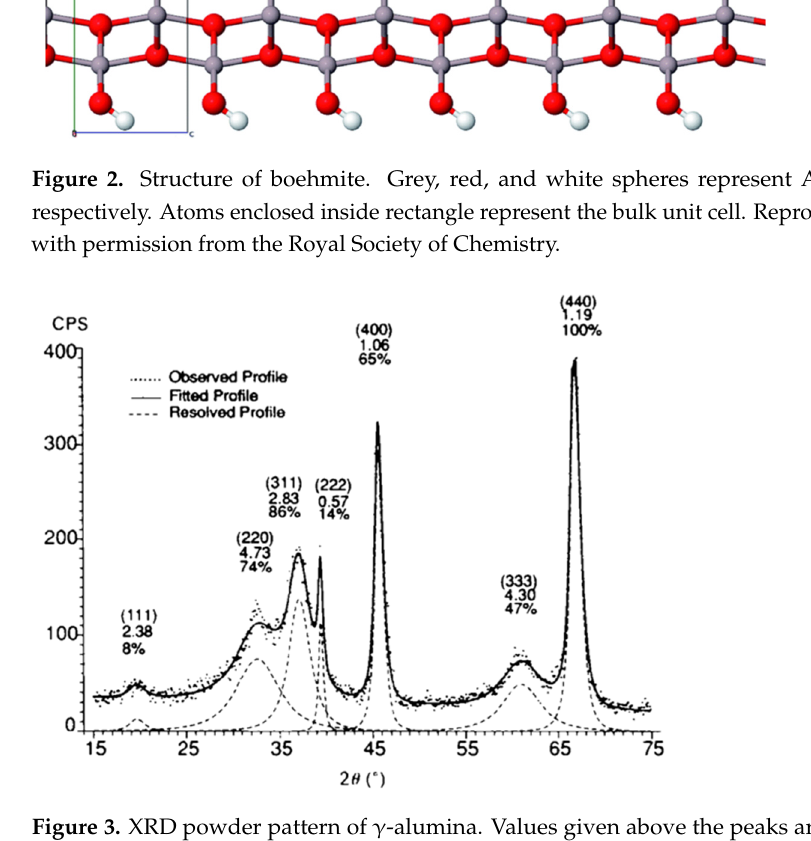
Figure 2. Structure of boehmite. Grey, red, and white spheres represent Al, O, and H atoms, re ‐ spectively. Atoms enclosed inside rectangle represent the bulk unit cell. Reproduced from Ref. [14] with permission from the Royal Society of Chemistry.